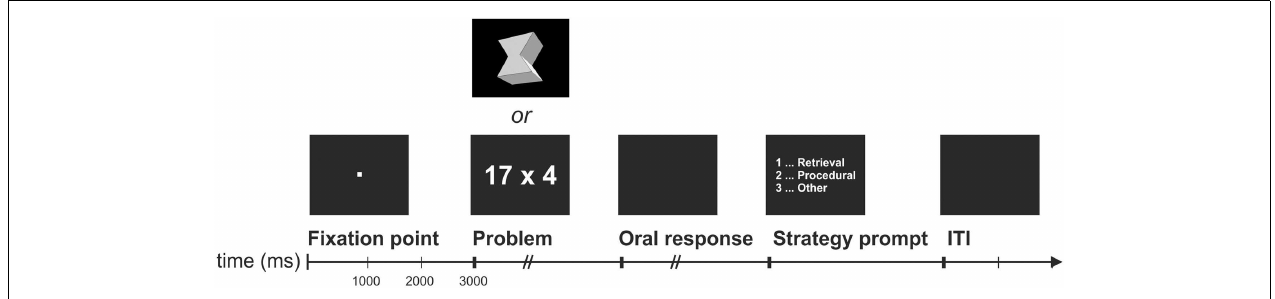
FIGURE 1 | Schematic display of one EEG trial. ITI, inter-trial interval of 2000ms length.